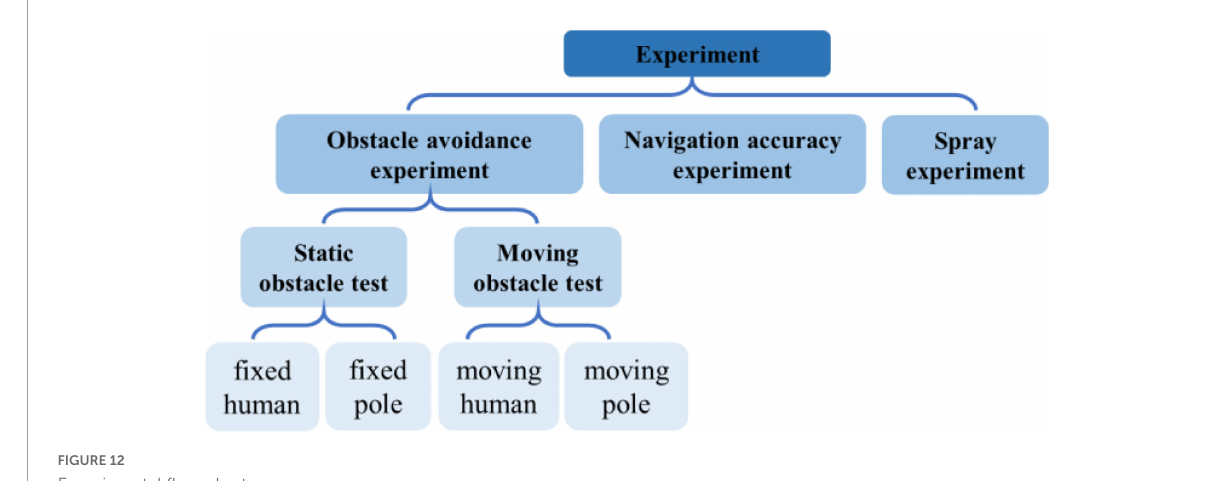
FIGURE12 Experimental flow chart.